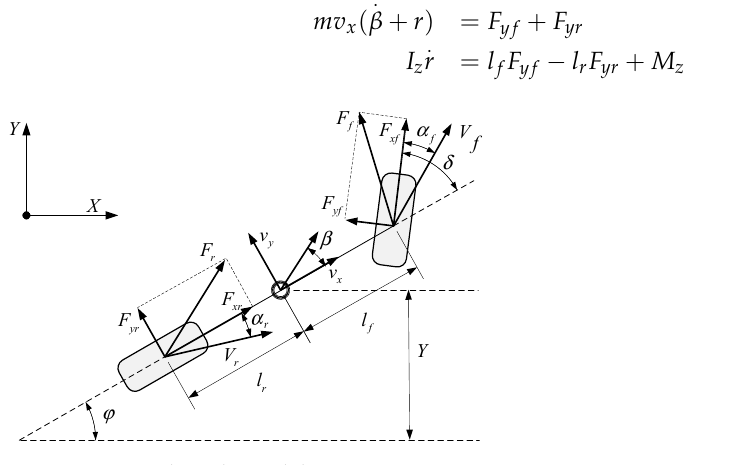
Figure 2. 2DOF bicycle model. can be calculated as follows, where the δ is the front wheel steering angle.